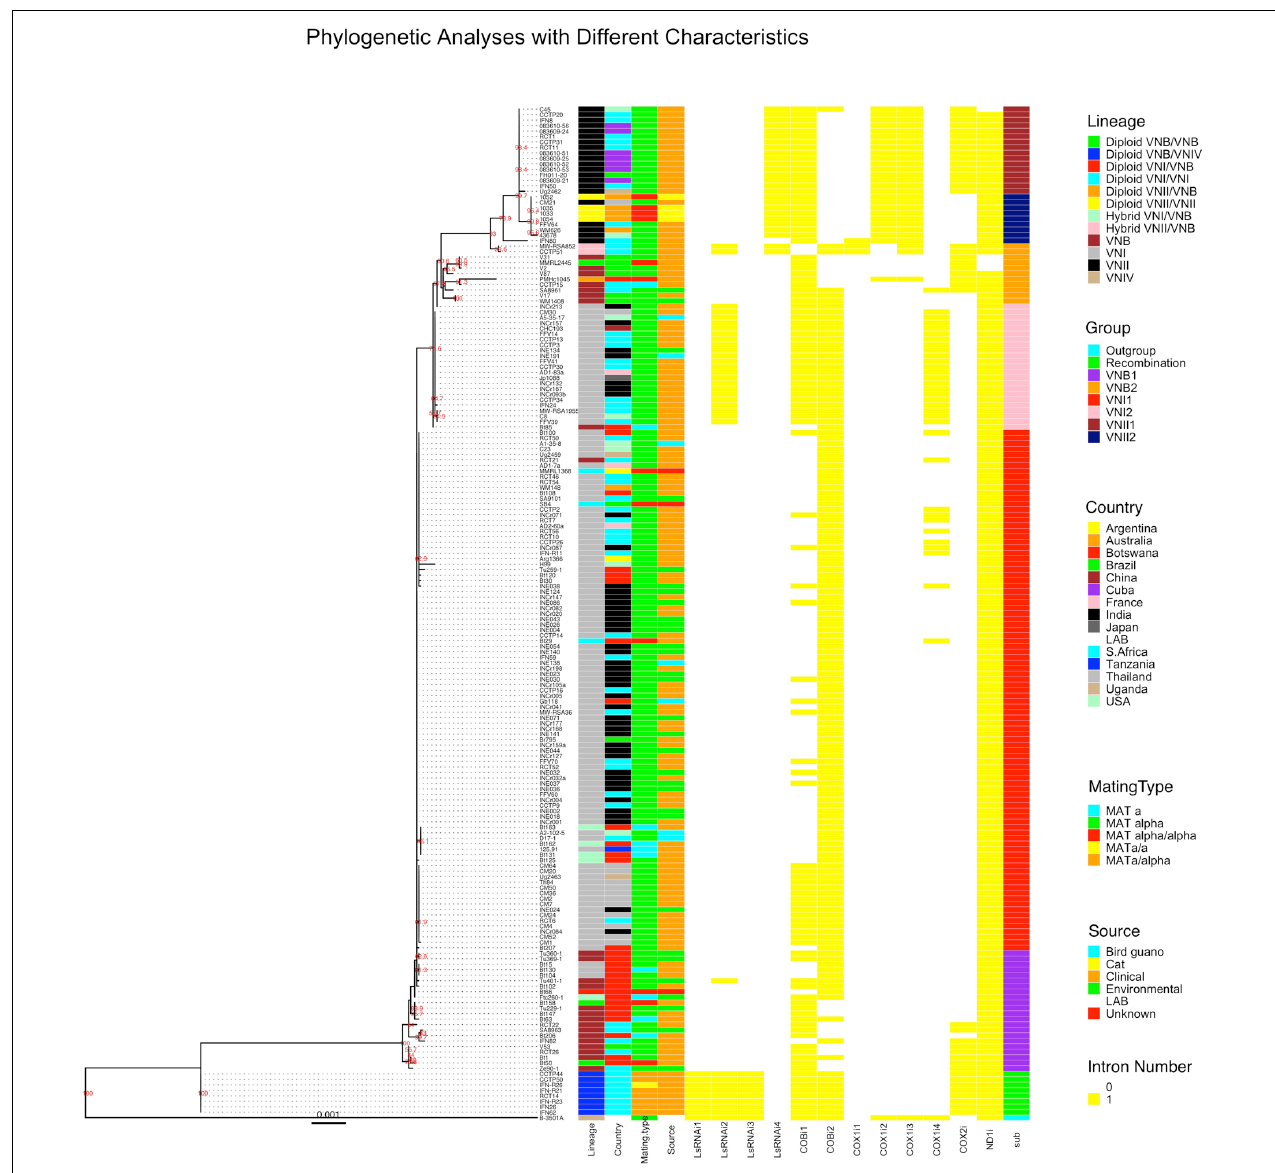
FIGURE 4 | Mitochondrial concatenated exon phylogenetic tree of the 184 strains and the distributions of strains’ lineage, country of origin, mating type, ecological niche, each of the 12 introns, and sub-clade categorization. The maximum likelihood tree was constructed based on concatenated sequences of all exons in the mitochondrial genome. Different characteristics were then mapped to the